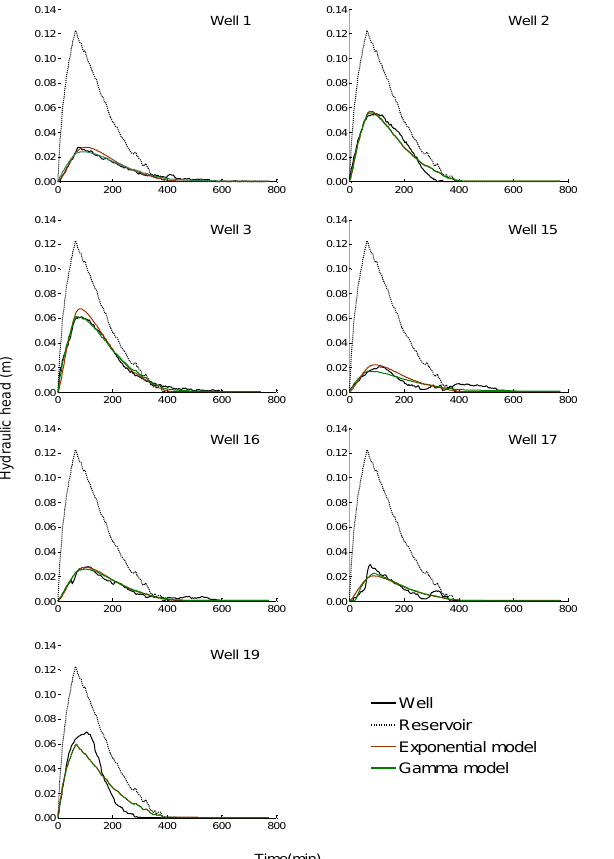
By comparison, tracer transport was generally slower and more spatially variable. The time delays between water en- tering the reservoir and chemical responses in the wells var- ied between 21–636 min for the best-fit models in the no- salt test and between 4–160 min for the best-fit models in the salt-added test. Mean residence times were much longer: between 2.2 × 10 3 and 2.0 × 10 6 min for the best-fit mod- els in the no-salt test, and between 1.5 × 10 2 and 1.0 × 10 6 for the best-fit models in the salt-added test. The orders-of- magnitude difference between the time until arrival of tracer and the MRT is a reflection of long residence times in the tails of the optimized distributions. Effective hydraulic con- ductivity estimates derived from the best-fit modeled tracer transport rates were between 1.4 × 10 and 1.1 × 10 3 md − 1 for the no-salt and between 2.4 × 10 − 1 and 1.7 × 10 3 m d − 1 for the salt-added tests. Spatial variability of tracer transport was greater during the salt-added test than during the no-salt test. The mass